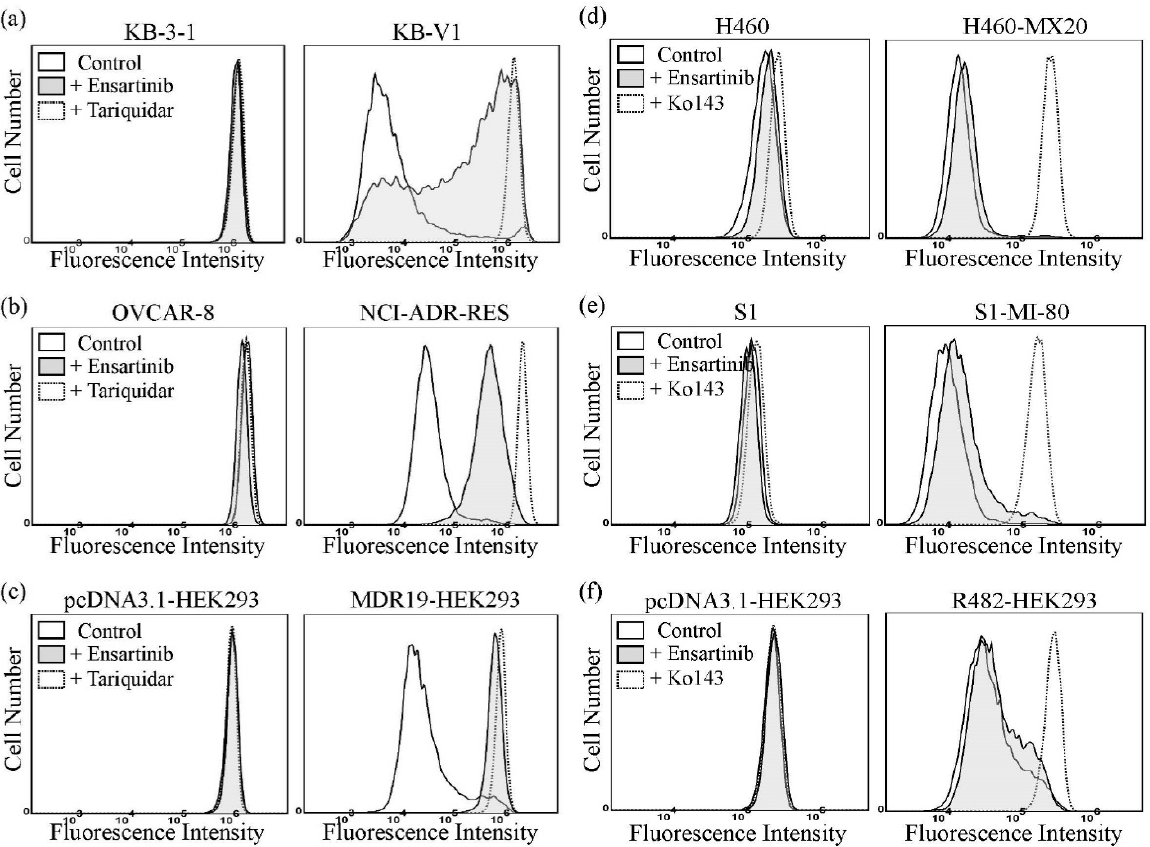
Figure 2. Ensartinib increases the intracellular accumulation of calcein in P-glycoprotein-overexpressing cells. The effect of ensartinib on the accumulation of the P-gp substrate drug calcein-AM ( a – c ) or accumulation of the ABCG2 substrate pheophorbide A ( d – f ) was determined in ( a ) KB-3-1 cells (left panel) and P-gp-overexpressing KB-V1 cells (right panel), ( b ) OVCAR-8 cells (left panel) and P-gp-overexpressing NCI-ADR-RES cells (right panel), ( c ) pcDNA3.1-HEK293 (left panel) and P-gp-transfected MDR19-HEK293 (right panel) cells, ( d ) NCI-H460 (left panel) and ABCG2-overexpressing H460-MX20 cells, ( e ) S1 (left panel) and ABCG2-overexpressing S1-MI-80 cells (right panel), and ( f ) pcDNA3.1-HEK293 (left panel) and ABCG2-transfected R482-HEK293 cells (right panel). Cells were treated with DMSO (control, solid lines), 10 μM ensartinib (filled solid lines), or 5 μM tariquidar ( a – c , dotted lines) as a positive control for P-gp or 5 μM Ko143 ( d – f , dotted lines) as a positive control for ABCG2. Cells were processed and analyzed as described in Materials and Methods. Representative histograms from at least three independent experiments are shown. Next, the effect of ensartinib on reversing MDR mediated by P-gp and ABCG2 was determined in P-gp- and ABCG2-overexpressing multidrug-resistant cells. The extent of reversal was determined by adding a non-toxic concentration of ensartinib, tariquidar or Ko143 to the cytotoxicity assays, and presented as a fold-reversal (FR) value as described previously [48,52]. Reversal assays revealed that, at the highest non-toxic concentration of 500 nM, ensartinib had no significant effect on P-gp-mediated resistance to the P-gp sub- strates paclitaxel, vincristine or colchicine [53] in P-gp-overexpressing KB-V1 and NCI- ADR-RES cancer cell lines, and the P-gp-transfected MDR19-HEK293 cell line (Table 2). Similarly, ABCG2-mediated resistance to the ABCG2 drug substrates mitoxantrone, topo- tecan and SN-38 [54,55] was not reversed by ensartinib in ABCG2-overexpressing S1-MI- 80 or H460-MX20 cancer cell lines, or in the ABCG2-transfected R482-HEK293 cell line (Table 3). Our results revealed that, although ensartinib could block P-gp-mediated drug efflux at higher concentrations, it could not resensitize P-gp- or ABCG2-overexpressing cancer cells to cytotoxic drugs at non-toxic low concentrations.